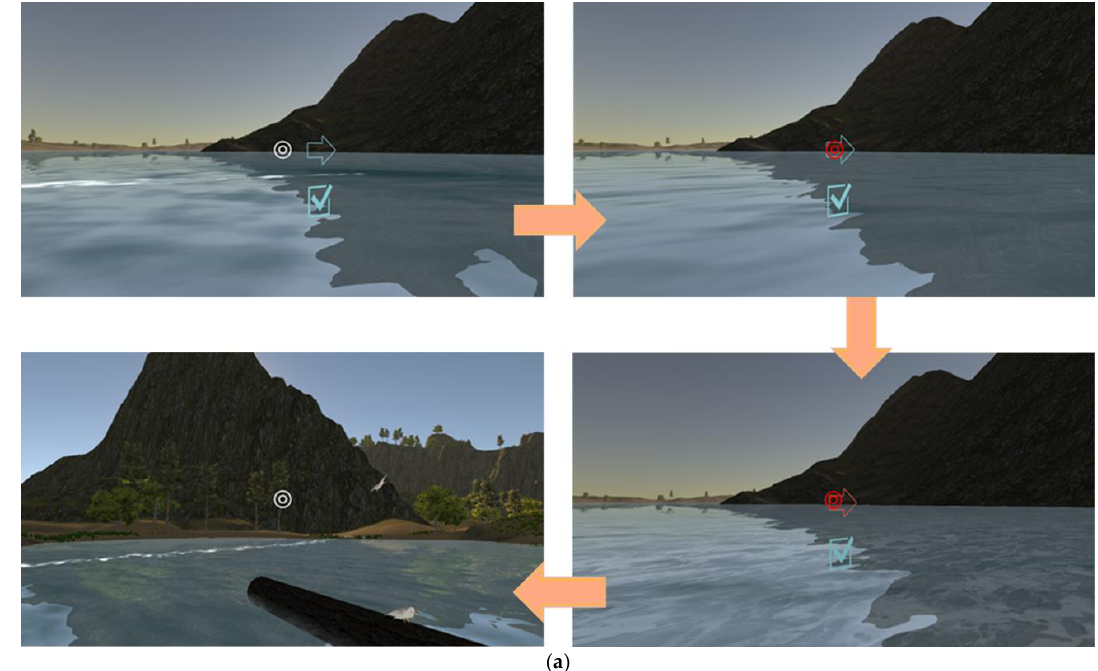
( b ) Figure 9. ( a ) Procedure for “going to next video clip . ” ( b ) Procedure for “going to previous video clip .”